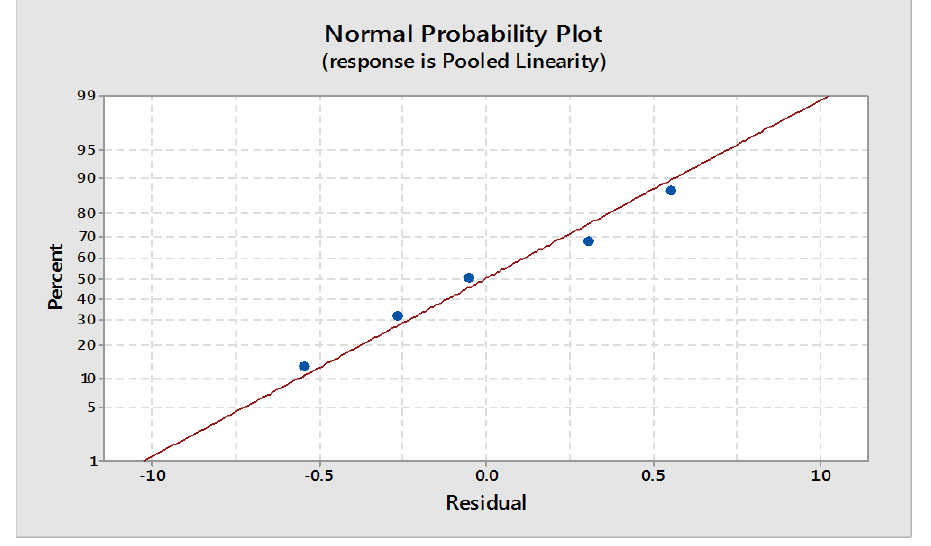
Figure 2. Q-Q graph for residuals from the linearity curve of Gentamicin Sulfate in PLM Table 1. Inhibition zone diameter (in mm) for Gentamicin Sulfate in USP buffer no. 3 for construction of the linearity curve